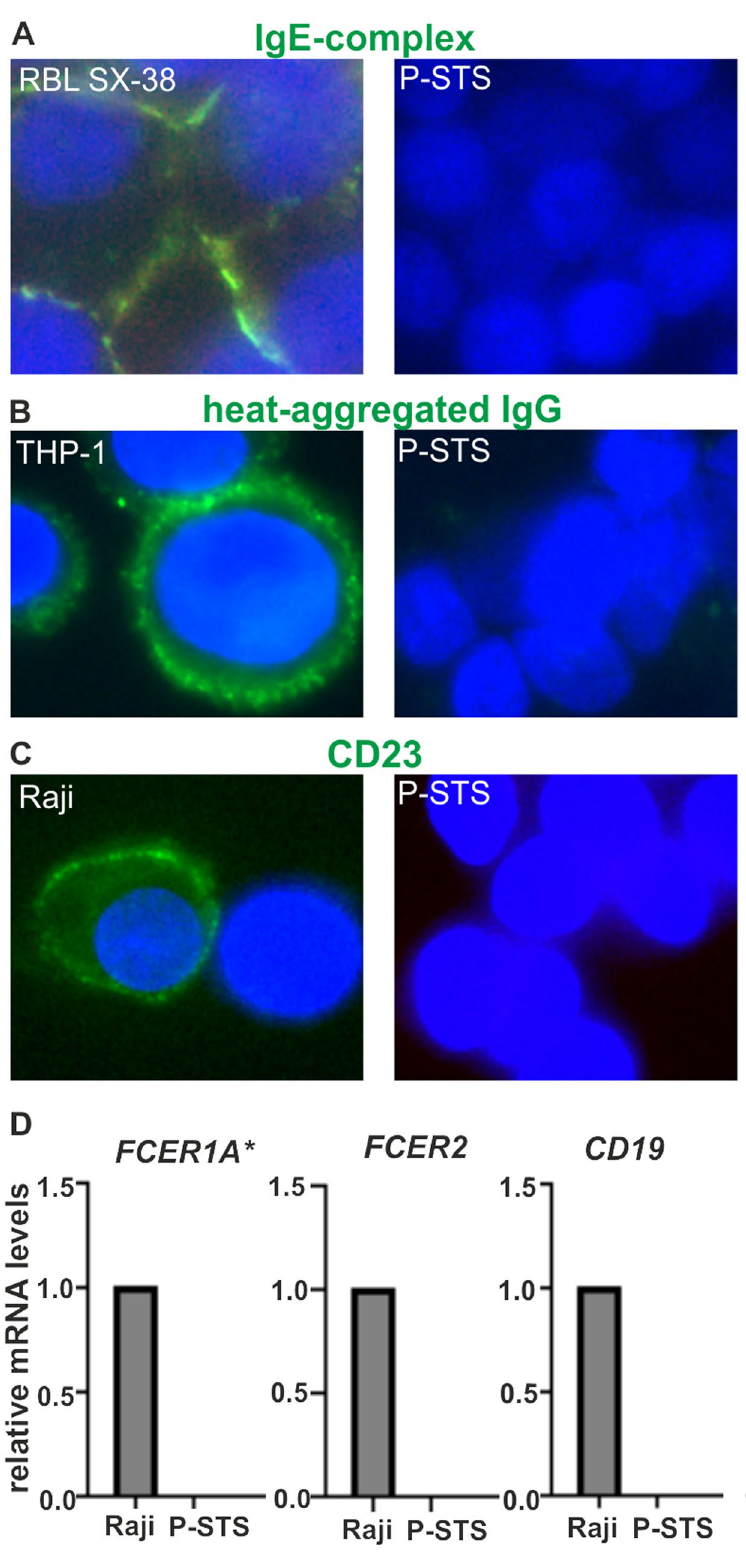
Figure 7. No IgG- or IgE-receptor expression was found in P-STS cells (age of culture < 6 months). ( A ) RBL SX-38 cells or Il-4 treated P-STS cells were incubated for 1 h at 37 °C with JW8/5/13 cell supernatant, washed two times with PBS and incubated for 1 h at 37 °C with NIP-BSA (100 ng ml − 1 ) in pure M199/Ham’s F12 medium. The cells were then prepared for immunofluorescence staining with FITC-labeled anti-IgE. ( B ) Heat- aggregated IgG (30 µ g ml − 1 ) was internalized for 15 min into THP-1 cells grown with 200 nM PMA for 2 d or P-STS cells grown for 3 d with 1 µ g ml − 1 LPS, cells were fixed and prepared for immunofluorescence